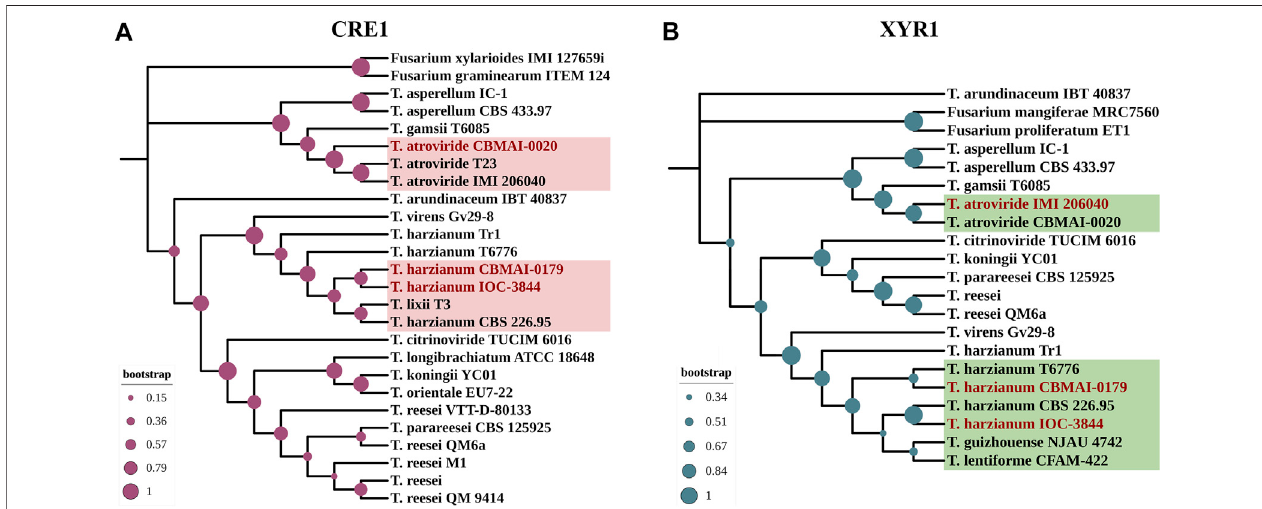
FIGURE 1 | Molecular phylogenies of CRE1 and XYR1 in Trichoderma spp. The 26 and 21 complete protein sequences related to CRE1 (A) and XYR1 (B) , respectively,wereusedtoinferthephylogeneticrelationshipsofthestudiedstrainsinthegenus Trichoderma .ClosegeneticproximitybetweenTh3844andTh0179was observed in the CRE1 phylogenetic tree, while Ta0020 shared a closer af fi nity with other T. atroviride strains. In the XYR1 phylogenetic tree, Th3844, Th0179, and Ta0020 were closest to T. harzianum CBS 226.95 , T. harzianum T6776, and T. atroviride IMI206040, respectively. Fusarium spp. was used as an outgroup. The bootstrap value is represented in each node. The phylogenetic trees were constructed using MEGA7 software and edited using the iTOL program.